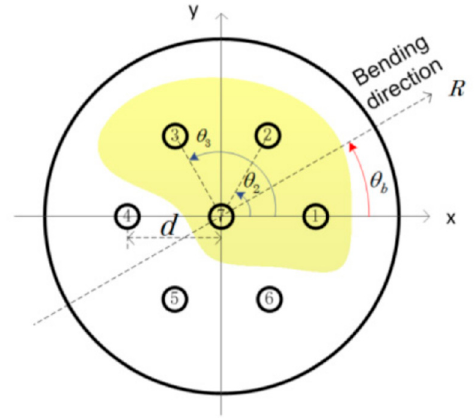
Figure 9. Transversal distribution of the fiber cores with the definition of the important geometrical parameters in seven-core fiber [8].